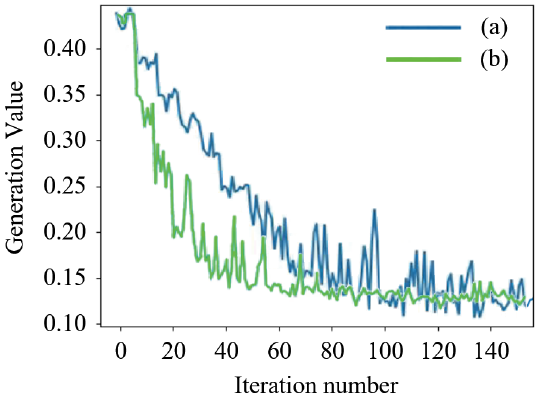
Figure 8. Algorithm training iterative process. ( a ) BP neural network training iterative process. ( b ) Model-driven deep learning training iterative process.